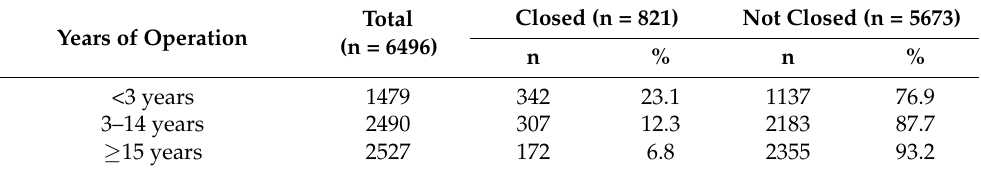
Table 2. Number of closures and the closure rate of home-visit nursing agencies by years of